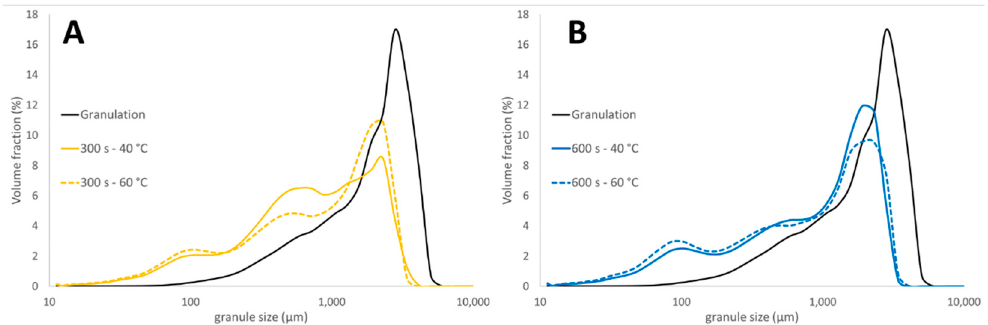
Figure 8. Granule size distribution to study the effect of drying air temperature on granule size after 300 ( A ) and 600 s ( B ) of drying.